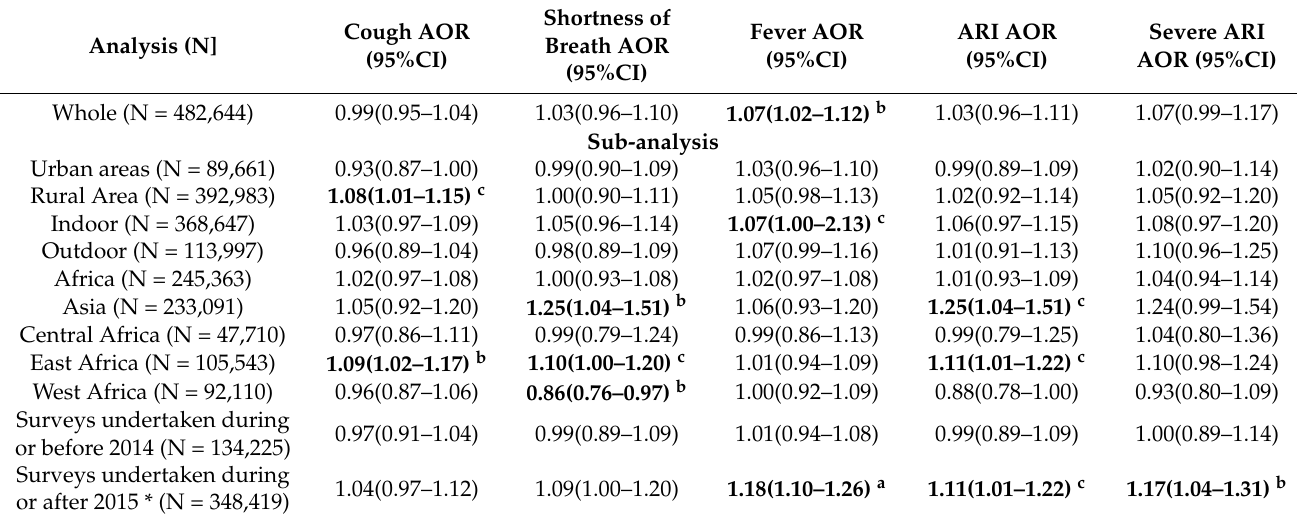
Table 2. Summary effects (AOR–95% CI) for respiratory symptoms, ARI and severe ARI with wood cooking of the whole, exploratory and